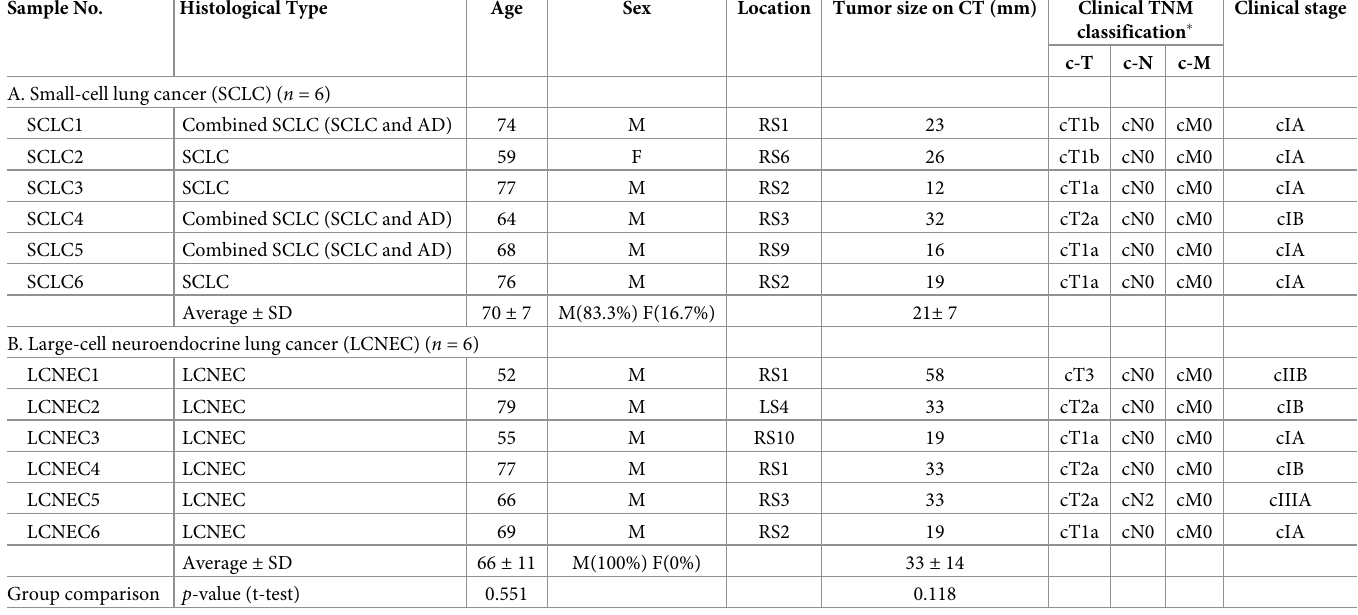
Table 1. Clinicopathological information of patients. Sample